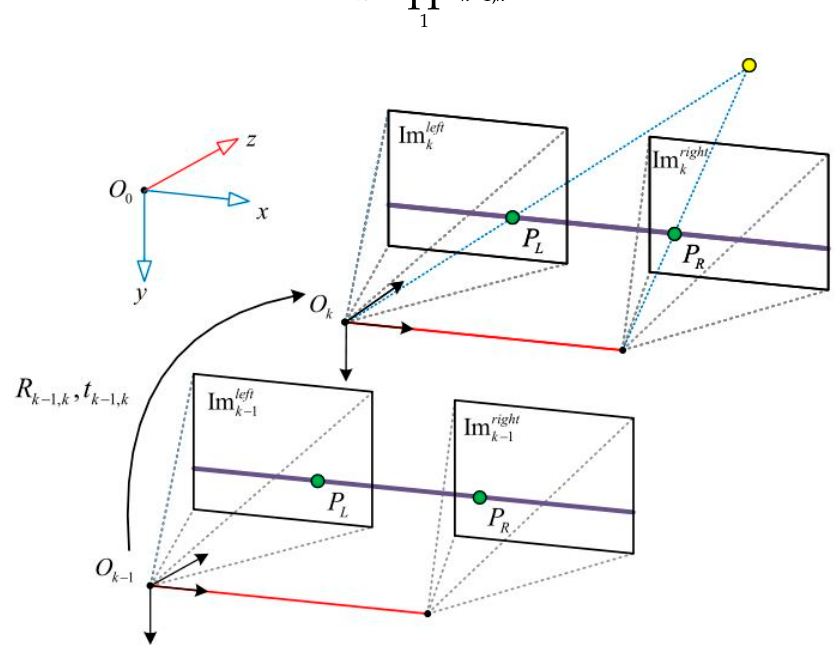
Figure 4. Binocular camera coordinate system diagram.